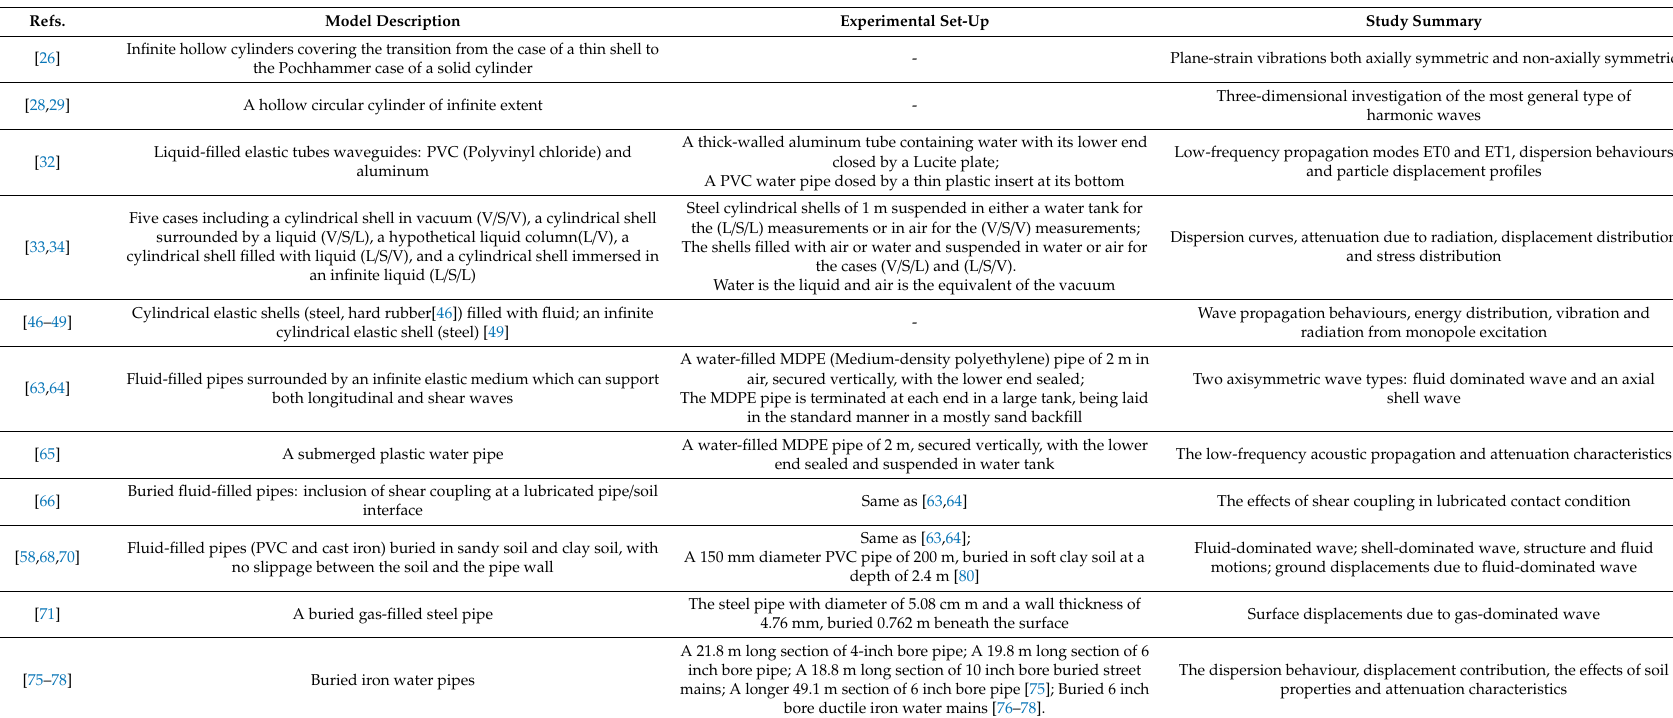
Table 1. Summary of the theoretical study on wave propagation in pipe